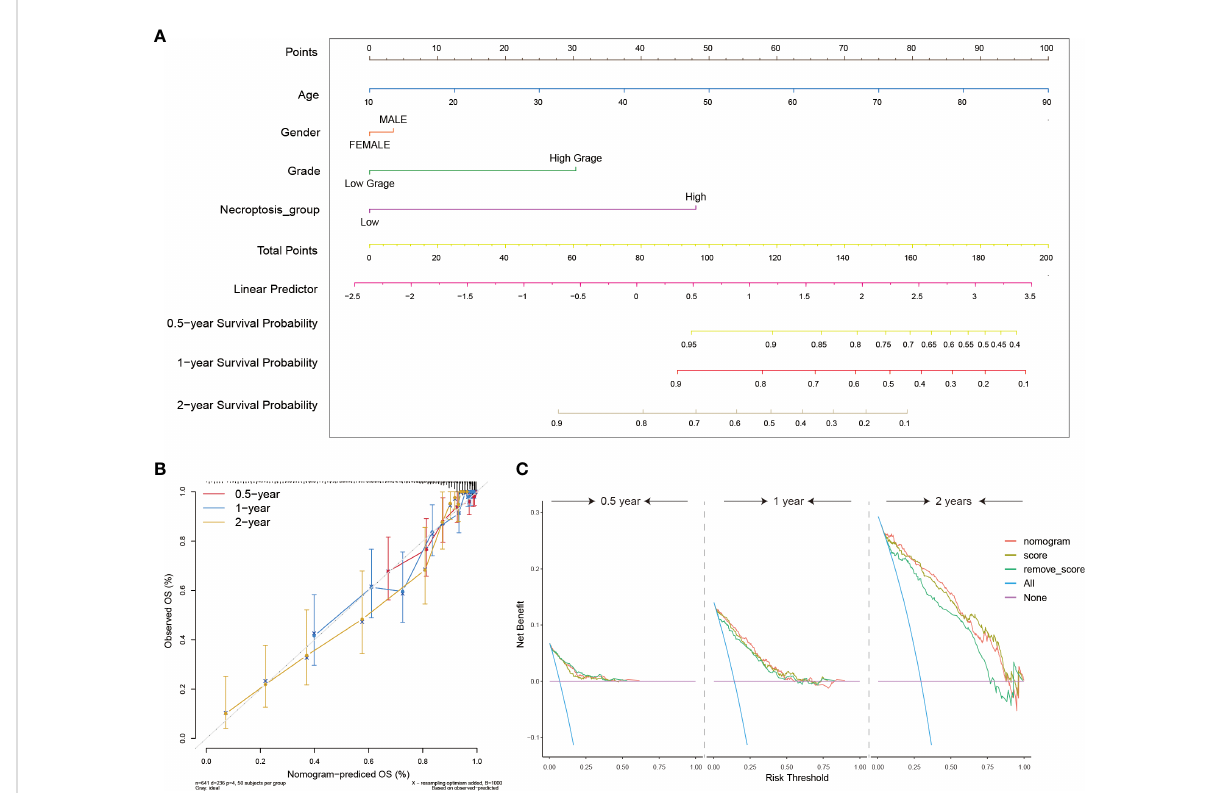
FIGURE 6 Construction of clinical utility nomograms with the NRS. (A) The nomogram included patients ’ age, gender, grade, and NRS groups for predicting the 6 months, 1-, and 2-year survival probability of glioma patients. (B) Calibration curves showing accuracy and speci fi cation of the nomogram and its association with actual clinical effects. (C) The DCA analysis of the nomogram for 6-months, 1- and 2-year survival